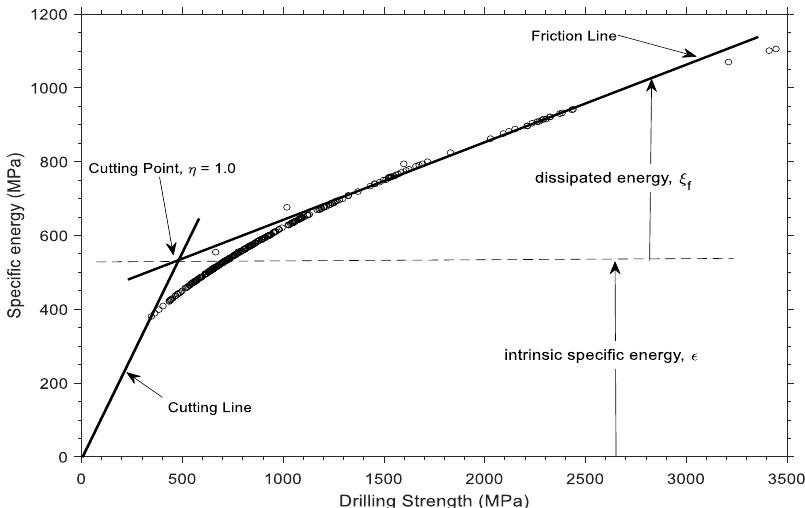
Figure 8. Graphical representation of specific energy and drilling strength. Marker data are calculated based on drilling measurement data utilized in this study, and solid lines are tangent to these data to build cutting and friction